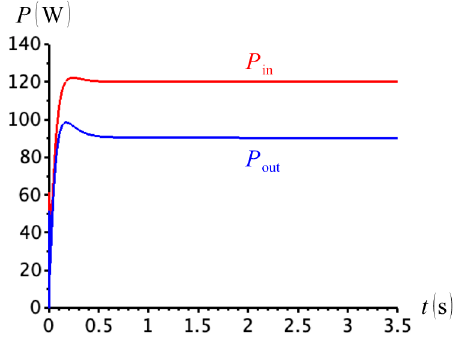
Figure 26. Power flows into and out of the cylinder.